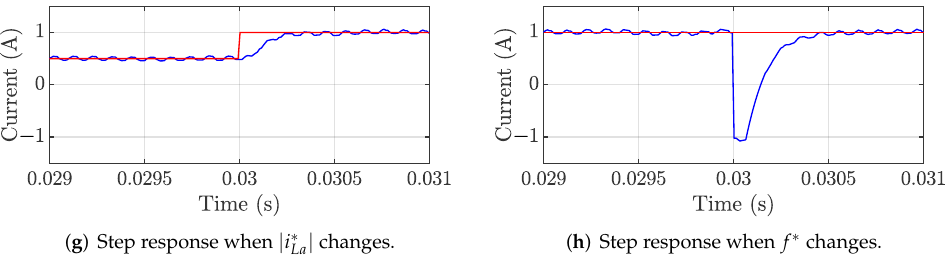
Figure 4. Simulation results for phase a ( a – f ) and i Ld ( g , h ), in transient conditions.